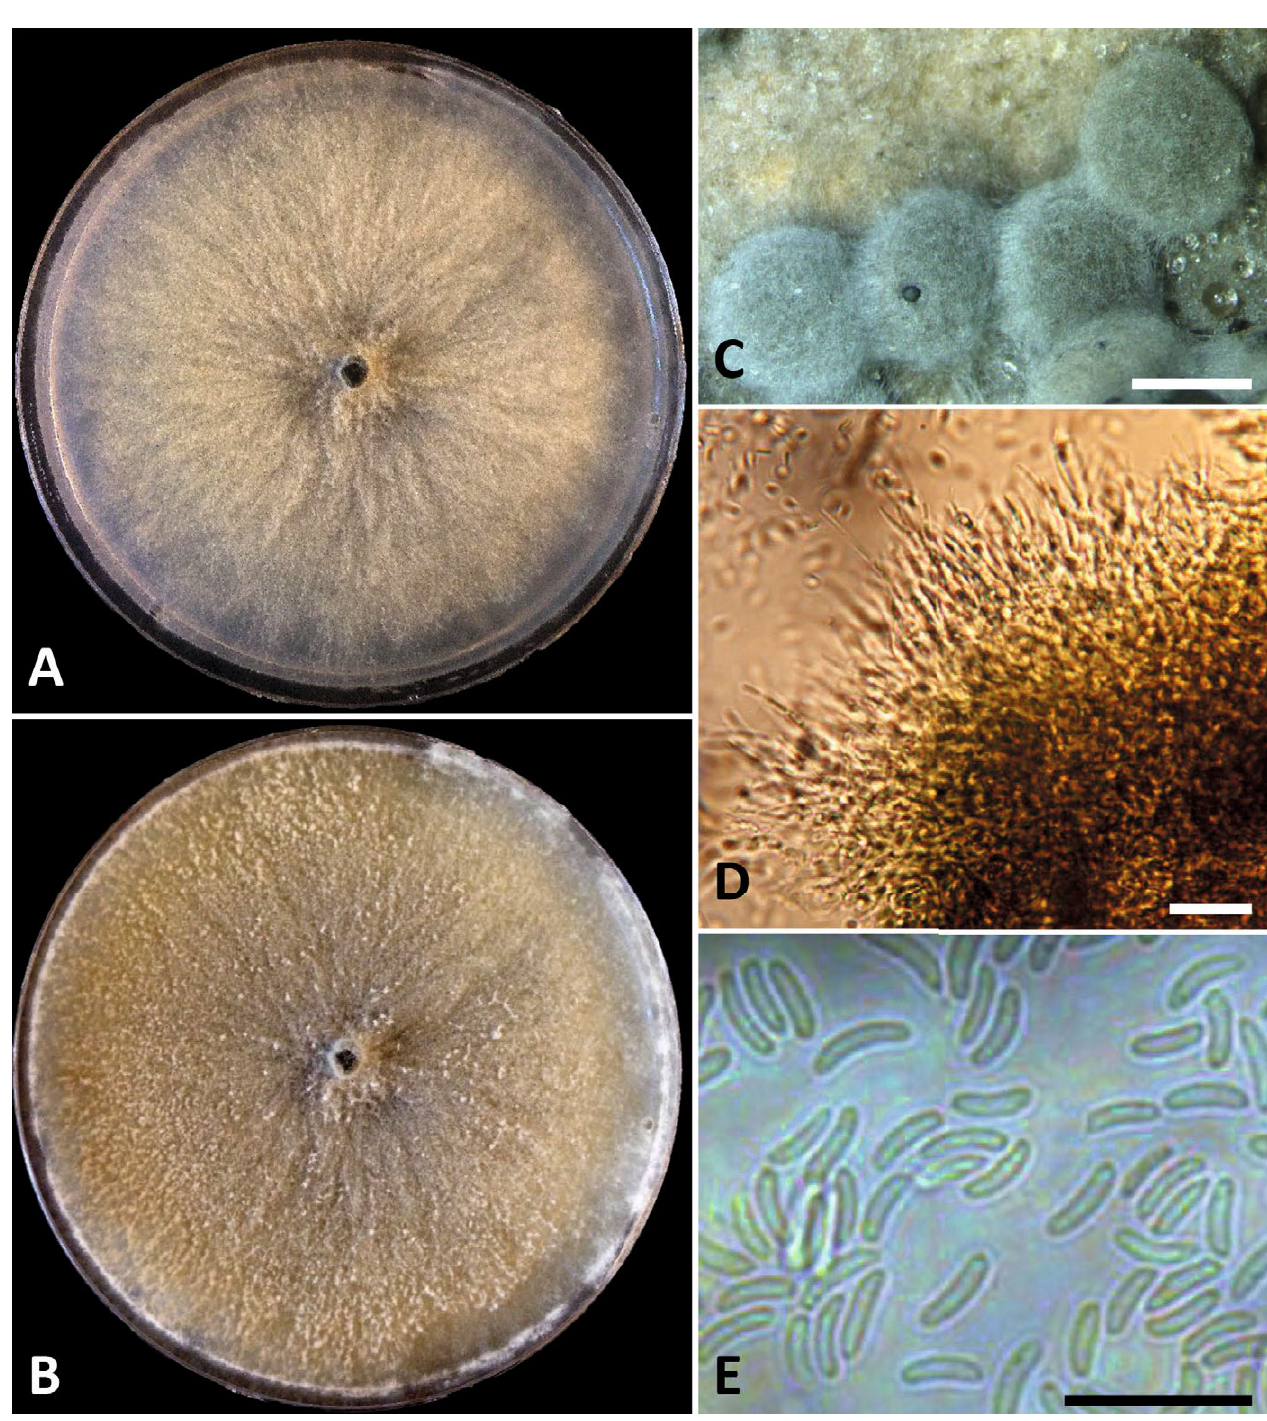
Fig. 15. Cytospora pistaciae (ex-holotype culture CBS 144238). A. Seven-day-old PDA culture. B. Fourteen-day-old PDA culture. C. Pycnidia. D. (cid:2){(cid:4)(cid:17)(cid:11)(cid:21)(cid:11)(cid:4)(cid:18)(cid:14)(cid:4)(cid:10)(cid:13)(cid:7)(cid:2)(cid:9)(cid:17)(cid:21)(cid:2)(cid:20)(cid:23)(cid:9)(cid:6)(cid:13)(cid:17)(cid:8)(cid:4)(cid:5)(cid:7)(cid:2)(cid:19)(cid:4)(cid:17)(cid:11)(cid:21)(cid:11)(cid:4)(cid:25)(cid:13)(cid:17)(cid:4)(cid:5)(cid:7)(cid:2)(cid:19)(cid:13)(cid:23)(cid:23)(cid:7)(cid:28)(cid:2) E. Conidia. Bars C = 1 mm; D = 10 μm; E = 20